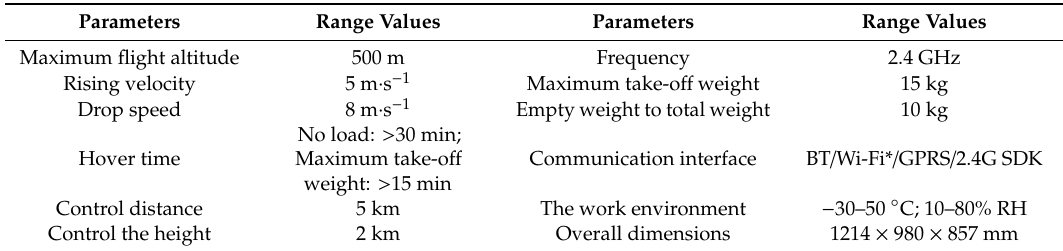
Table 1. General parameters of the unmanned aerial vehicles (UAVs) used in this